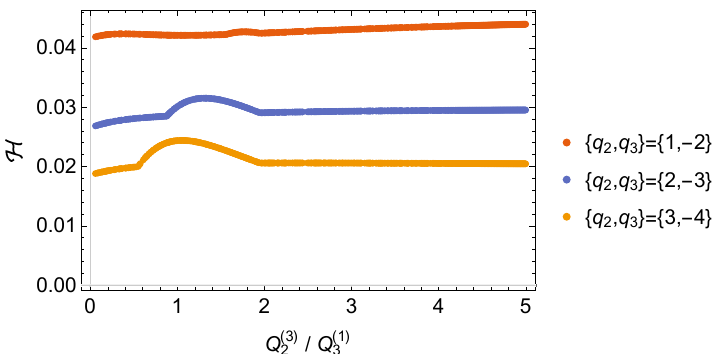
Figure 4 . The entropy parameter H as a function of one of the charge ratios for three di(cid:11)erent GH functions V with q = 1, k 1 = (cid:0) k 2 = k 3 = 1, Q